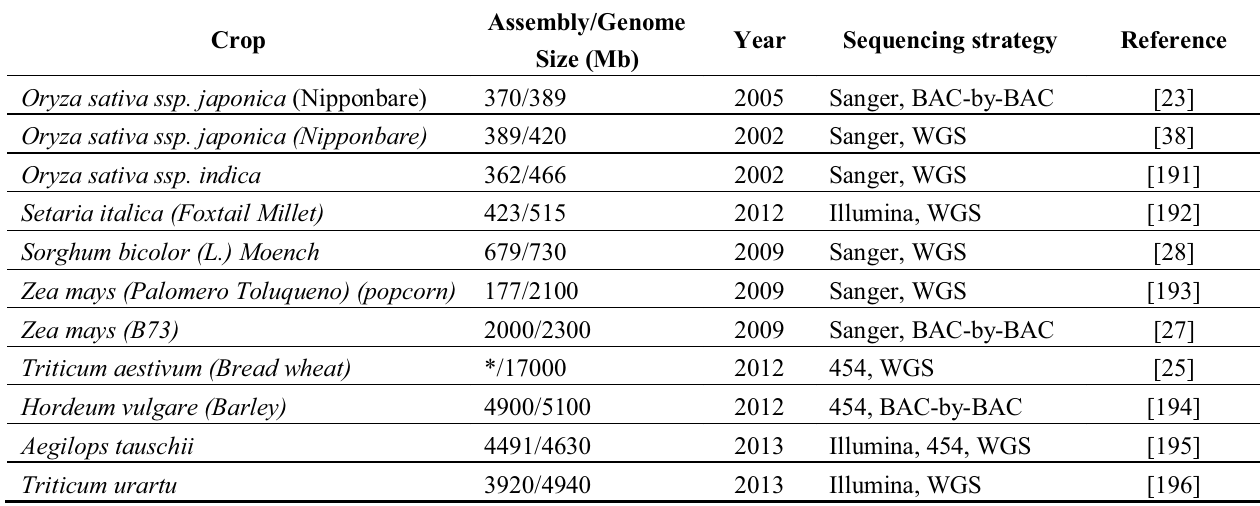
Table 1. Current sequenced cereal genomes. All assemblies are usually shorter than the predicted genome